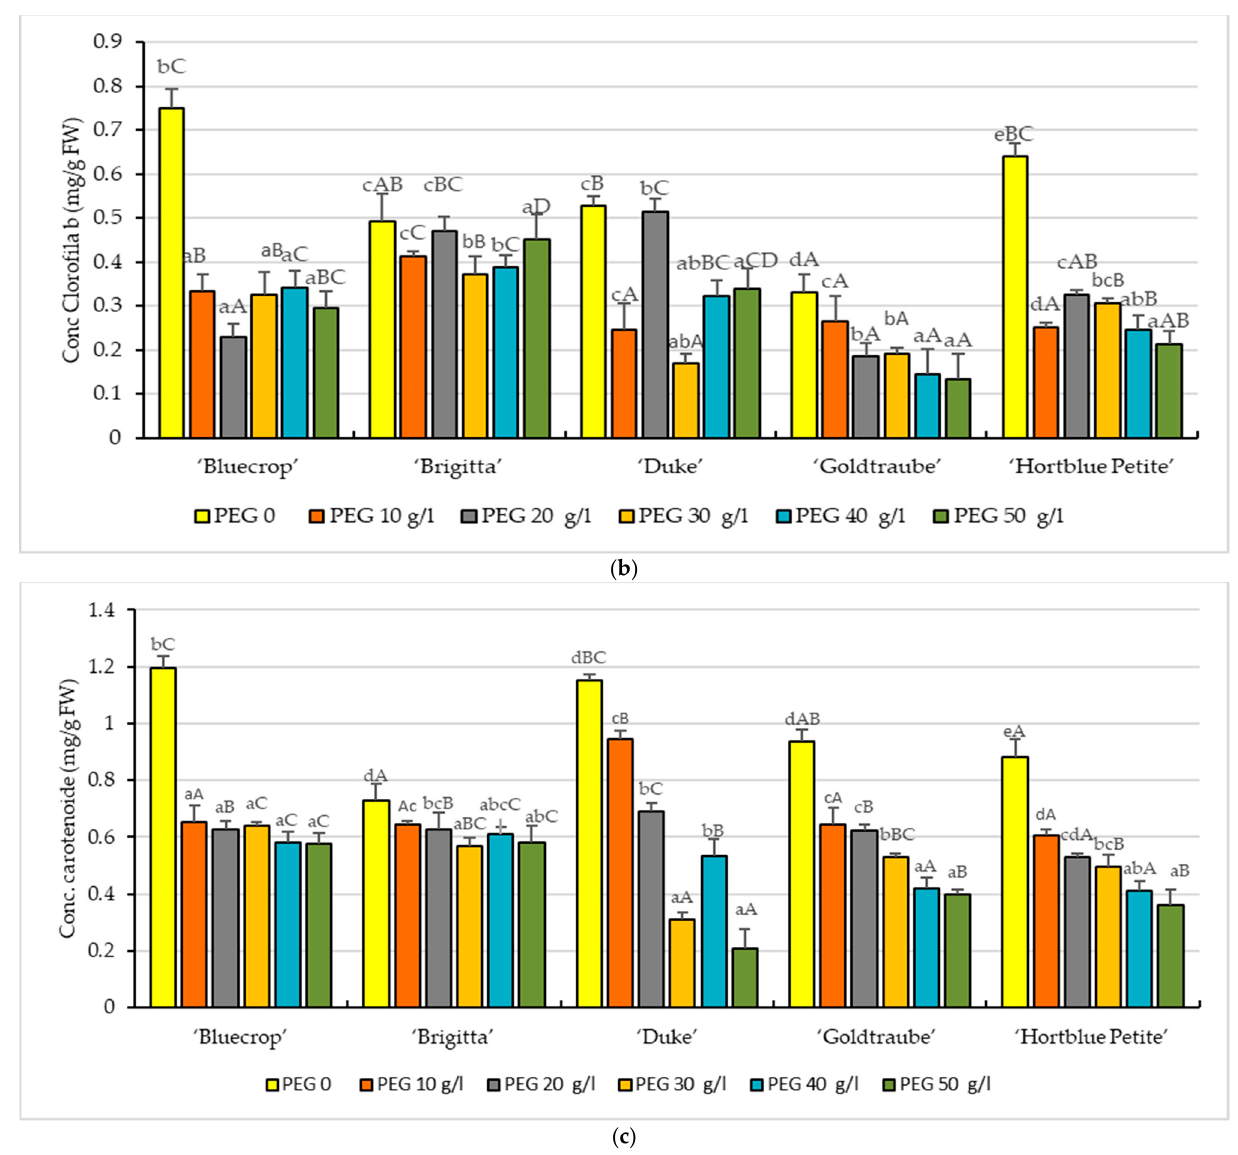
Figure 4. Photosynthetic pigments in the in vitro shots of the five highbush blueberry cultivars (Bluecrop, Brigitta Blue, Duke, Goldtraube and Hortblue Petite.): ( a ) chlorophyll a (Chl a), ( b ) chlorophyll b (Chl b) and ( c ) carotenoids (Caro) contents after 12 weeks of applied different concentrations polyethylene glycol (PEG 6000) (0 g/L, 10 g/L, 20 g/L, 30 g/L, 40 g/L, 50 g/L). Error bars indicate mean ± SE, and different lowercase letters within each cultivar indicate significant differences among the treatments and different capital letters indicate significant differences among the cultivars undergoing the same treatment according to Tukey’s HSD test ( p < 0.05).